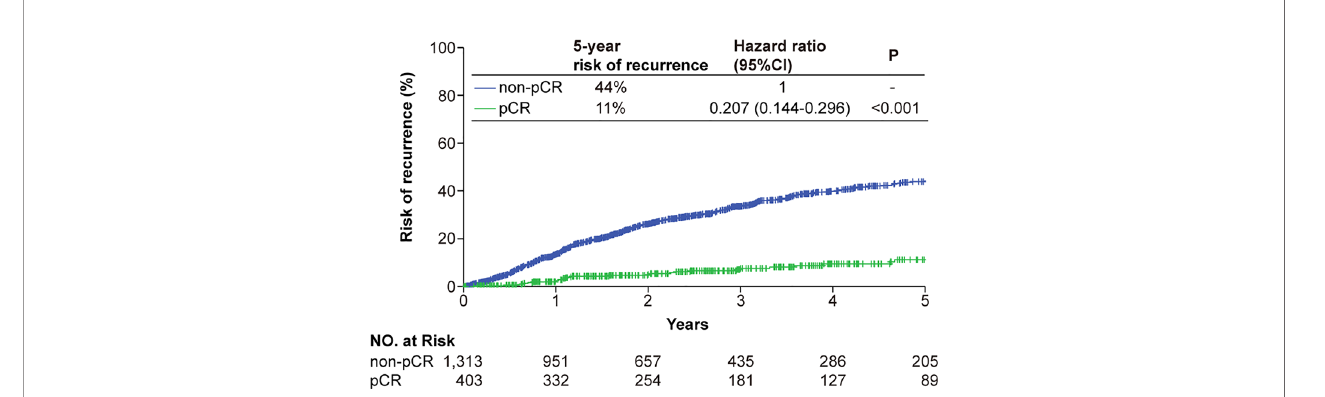
FIGURE 2 | Kaplan-Meier analysis of the risk of tumor recurrence classi fi ed by the pCR status. Patients achieving a tumor pCR had a signi fi cantly lower risk of tumor recurrence. Abbreviations: CI, con fi dence interval; pCR, pathologic complete